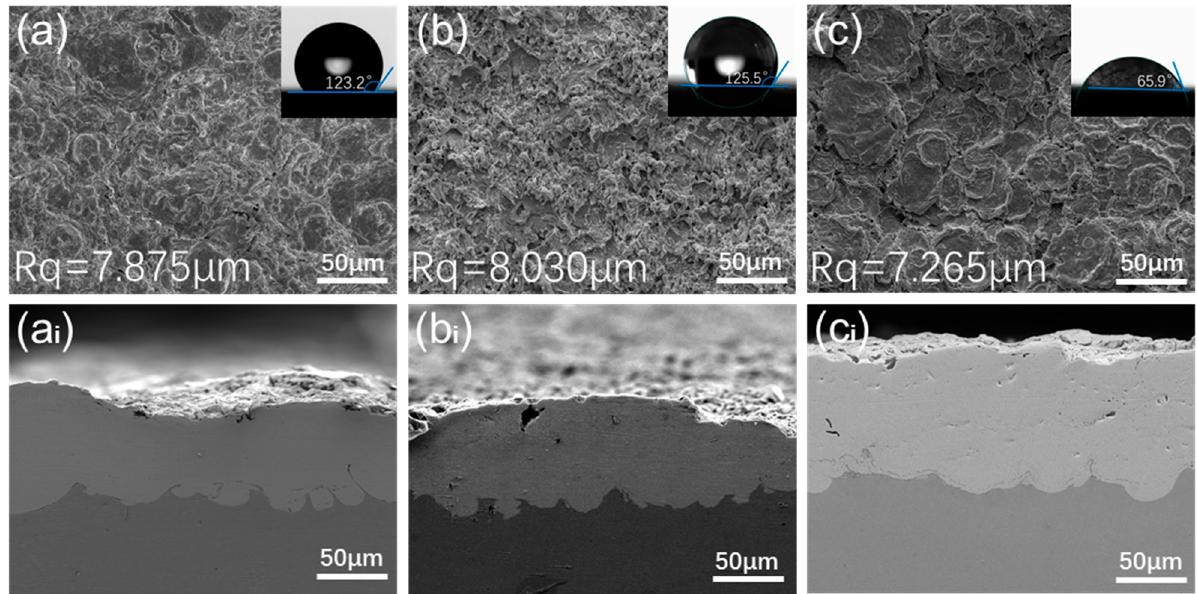
Figure 5. The surface and cross-sectional morphologies of the as-deposited and treated AgC coatings: ( a , ai ) for D-AgC, ( b , bi ) for L-AgC, ( c , ci ) for A-AgC, and the insets show the contact angles of each sample, respectively.